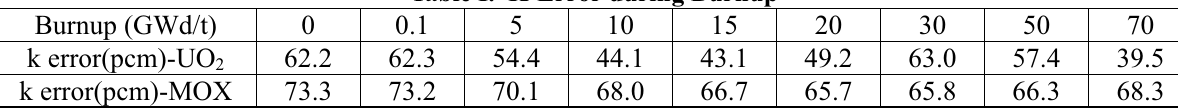
Figure 2. The Distribution of Relative Errors over Burnup Steps for Self-Shielded XSs Table I. K-Error during